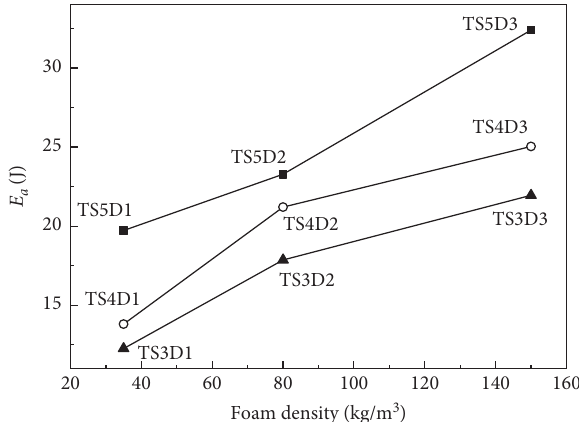
Figure 5: The effects of foam density on energy absorption of TFS